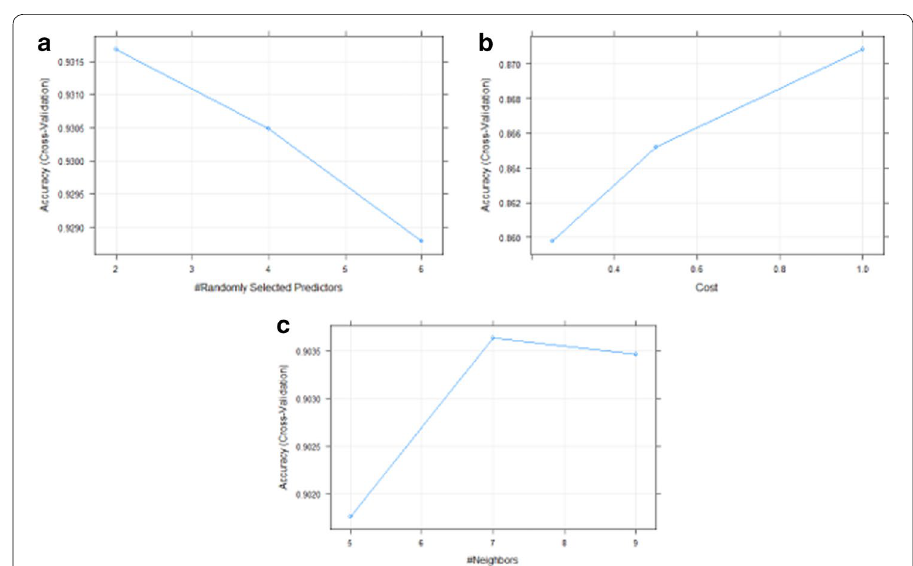
Fig. 13 Feature selection and classification method combination for Human Activity Recognition Using Smartphones Dataset a RF